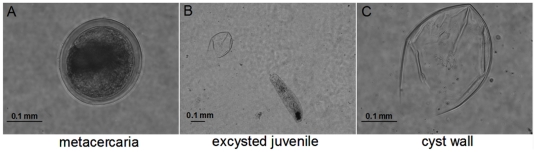
Microscopical examination of C. sinensis metacercariae for cyst wall proteins.(A) Intact metacercaria (×400); (B) Excysted juvenile, juvenile immediately moved out (×100); (C) Cyst wall (×400). Bar = 0.1 mm.